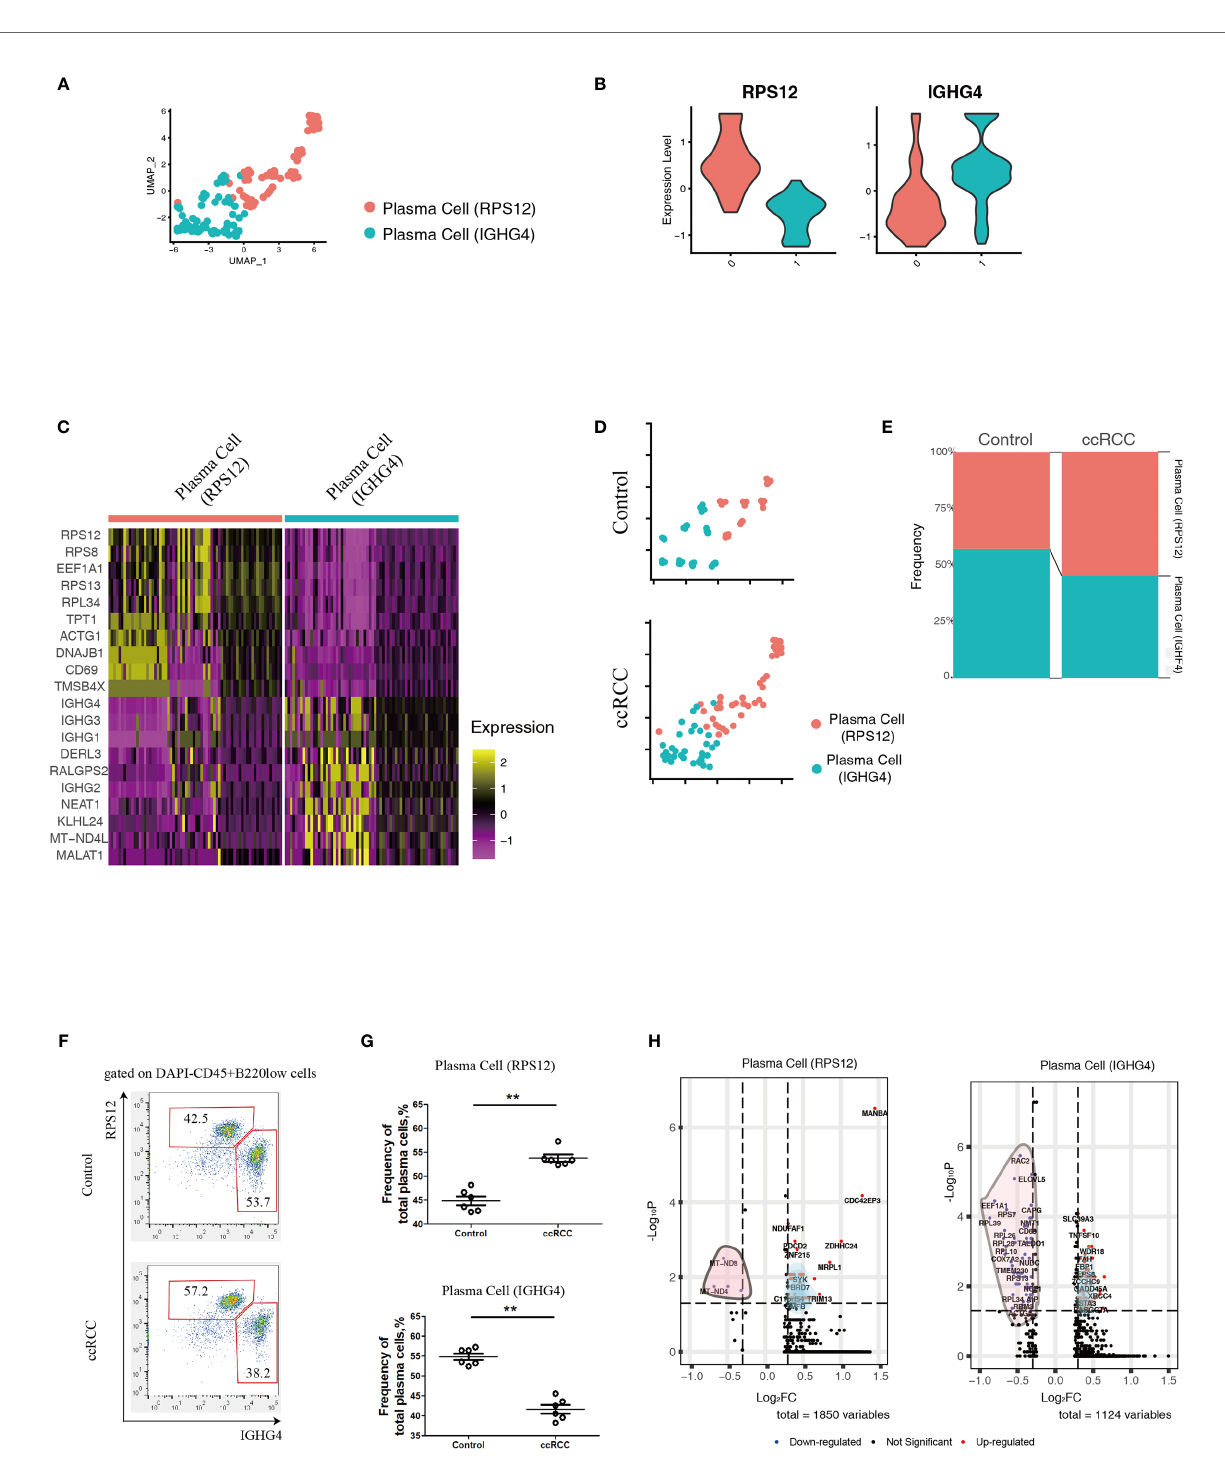
FIGURE 4 | Analysis of Plasma Cell Subpopulations By scRNA-seq And Flow Cytometry. (A) A UMAP plot showing the subpopulations of plasma cells after performing integration of control kidney and ccRCC plasma cells. (B) Violin plots showing the distribution of the two featured genes (RPS12 and IGHG4) in integrated plasma cells. (C) Heatmap showing the heterogeneity of the top 10 genes expressed in the two plasma cell subpopulations. (D) Split UMAP plots showing the comparison of plasma cell subpopulationsbetween controlkidneys and ccRCC biopsies. (E) Stacked bar plots showing the comparisonof plasma cellsubpopulations between control kidneysand ccRCC biopsies. (F) Flow cytometry analysisof plasma cellsubpopulationsincontrol kidneysand ccRCC biopsies. (G) Scatter plots showing the statistical analysis of the two plasma cellsubpopulationsincontrol kidneysand ccRCC biopsies. Each dot represents one readout. The data represent3 independent experiments. (H) Volcanoplots showingthe distribution of DEGs (ccRCC vs. Control) inthe two plasma cellsubpopulations.